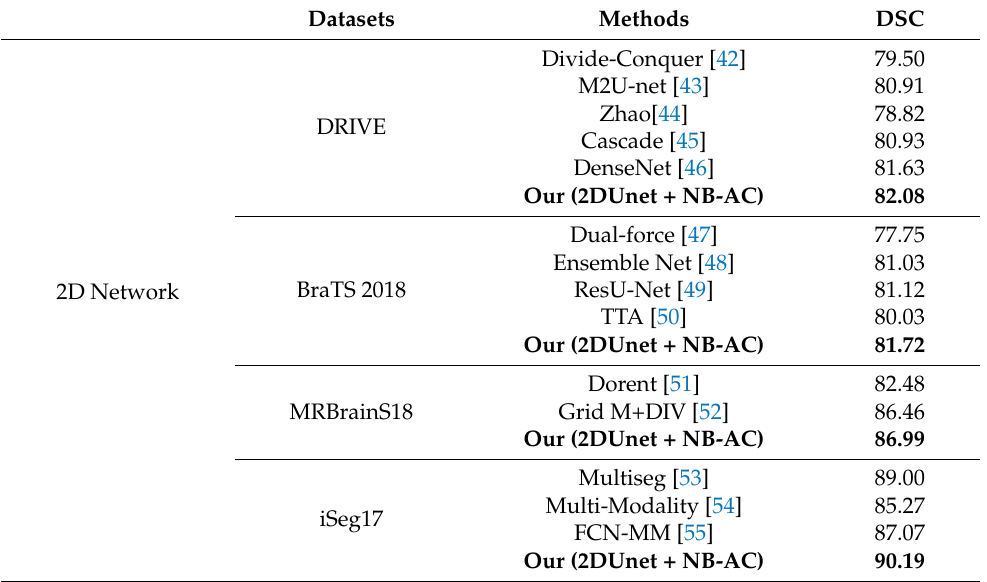
Figure 12. Visualization of the white matter surface of the existing loss functions on the iSeg17 dataset where differences in topology are indicated by red arrows. Table 5. Comparison of our proposed NC-AC loss on both 2D-Unet [3] and 3D-Unet [4] against other state-of-the-art methods on medical datasets with Dice score